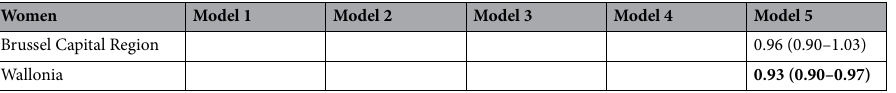
Table 4. Relative colorectal cancer incidence inequalities among the study population aged 50 to 74 years by gender and migrant origin, adjusted for age and sociodemographic and socioeconomic indicators, Belgium, 2004–2013. Model 1 is adjusted for age at the start of the follow-up; Model 2 is adjusted for age at the start of the follow-up and civil status; Model 3 is adjusted for age at the start of the follow-up and educational attainment; Model 4 is adjusted for age at the start of the follow-up and home ownership; Model 5 is adjusted for age at the start of the follow-up and region at time of census. Results significant at the p < 0.05-level are in